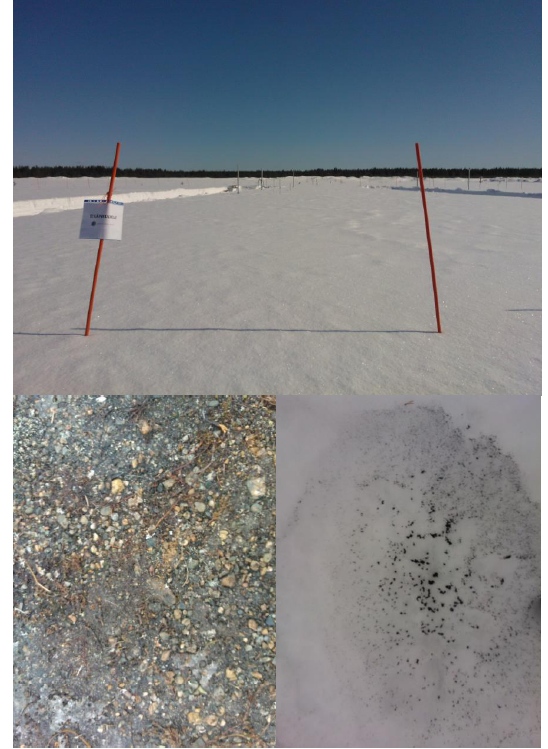
Figure 1. The SoS-2013 experiment. (a) Top: the flat and open ex- perimental field with the seasonal snow pack; (b) bottom left: the ground under the snow, i.e. a natural gravel surface, not covered by concrete or asphalt, offered an uniform surface for the snow cover; (c) bottom right: previously added impurities were visible on the surface of the melting snow, here volcanic